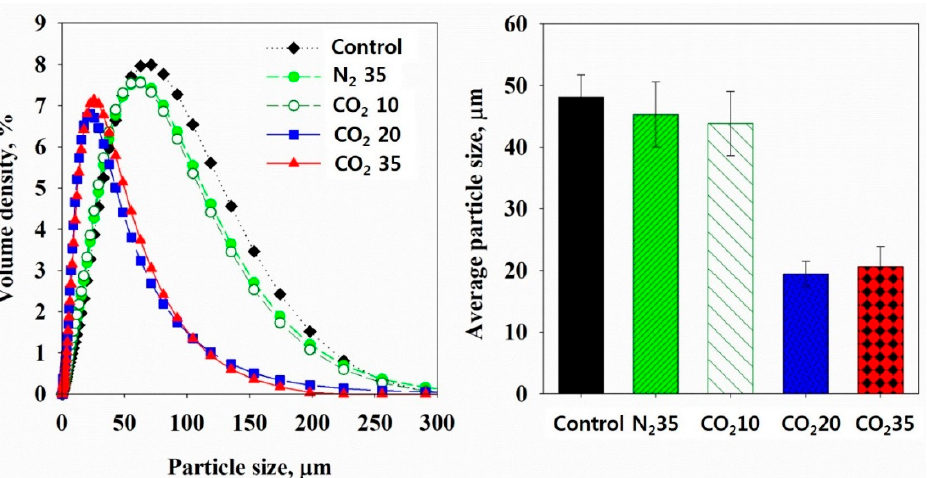
Figure 8. Particle size distribution ( left ) and average particle size ( right ) of sludge in the μ m range.